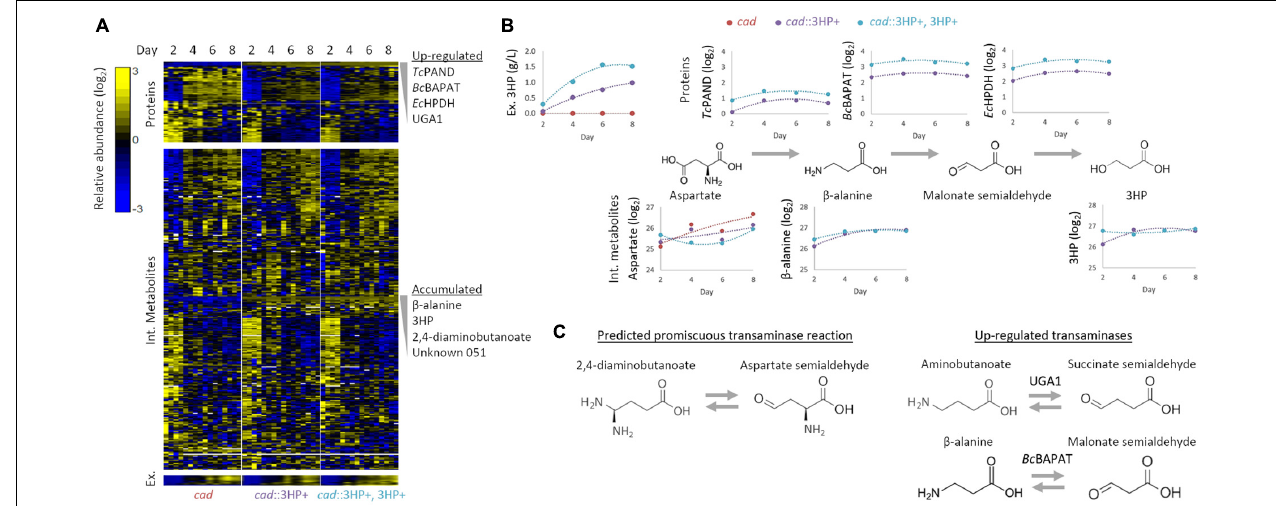
FIGURE 2 | Multi-omics analysis of 3HP producing A. pseudoterreus strains. (A) Profiling of intracellular and extracellular metabolites and targeted proteomics of central metabolic pathways. (B) Effect of establishment and increase in production level on enzymes and metabolites in the engineered 3HP metabolic